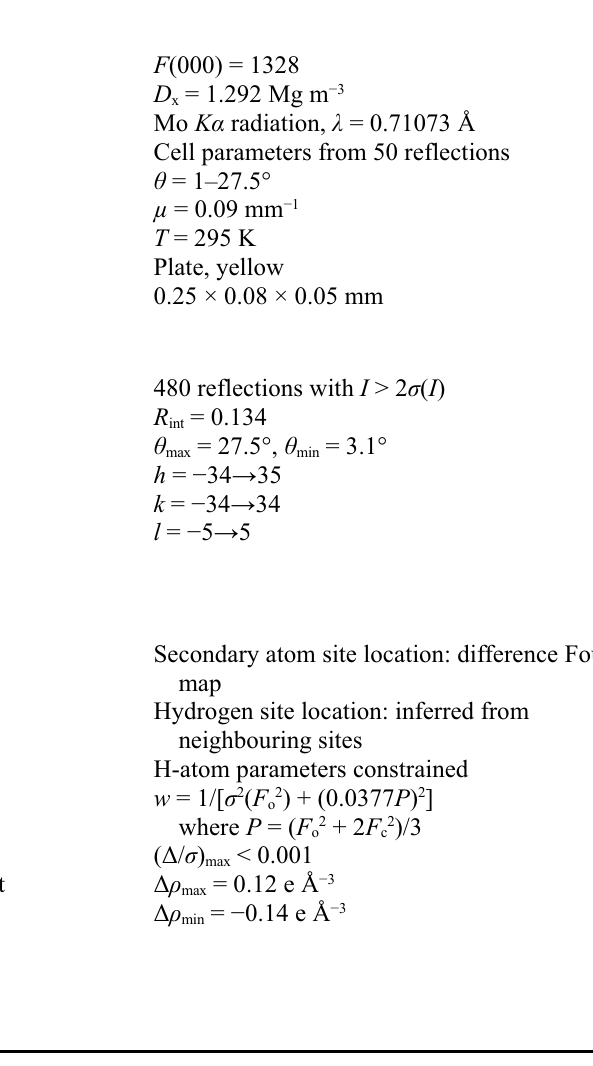
Figure 1 ORTEP projection of the title molecule. Symmetry equivalent atoms are generated by the symmetry code [- x , 1 - y , z ]. Intramolecular bonds are indicated by dashed lines. Thermal ellipsoids are shown at the 50% probability level.